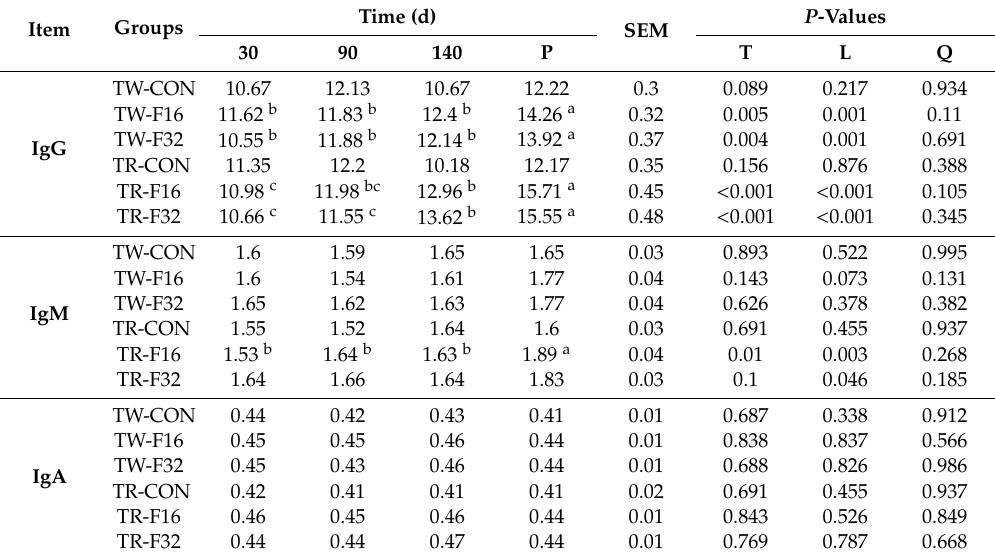
Table 6. Variance of immunoglobulin in serum from 30 days after mating to parturition (g /